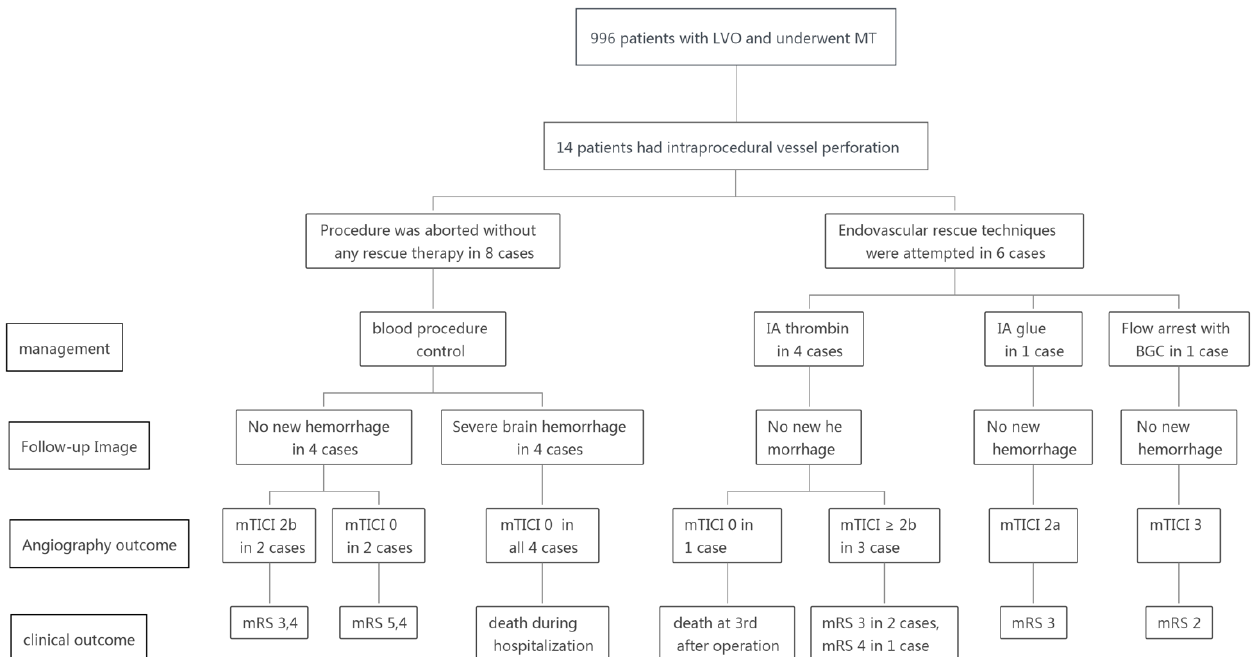
Figure 1. Diagram of management and outcome of patients with intraprocedural vessel